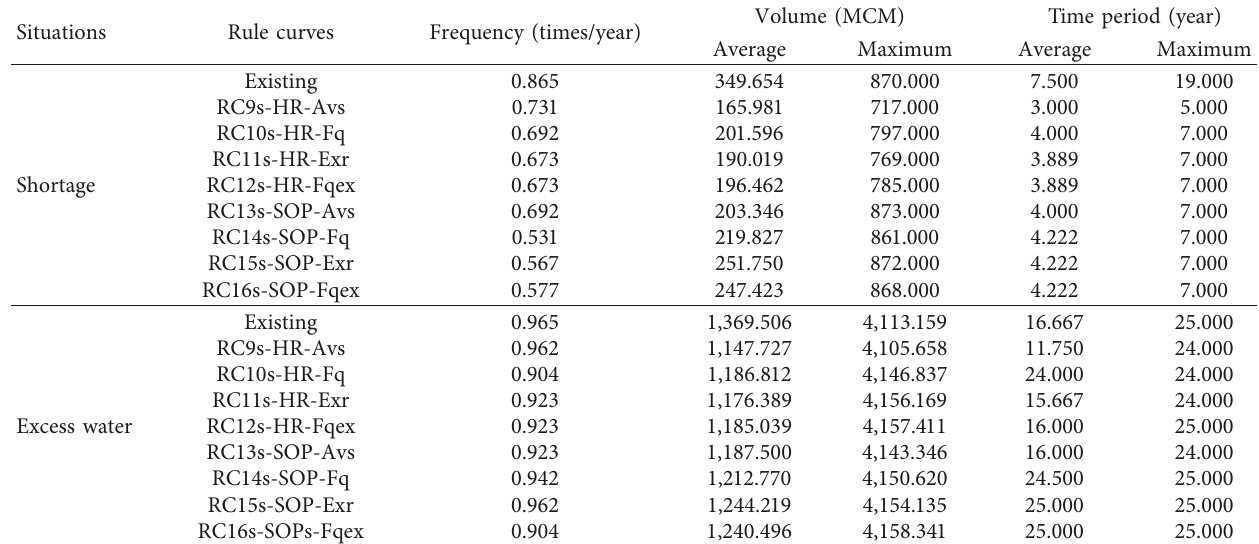
Table 5: The situations of water shortage and excess water considering historic inflow 52years from MPA considering sedimentation and using SOP